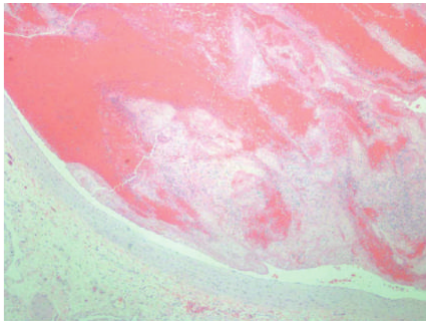
Figure 4: Laminated thrombus within the pulmonary artery (H&E 100x).